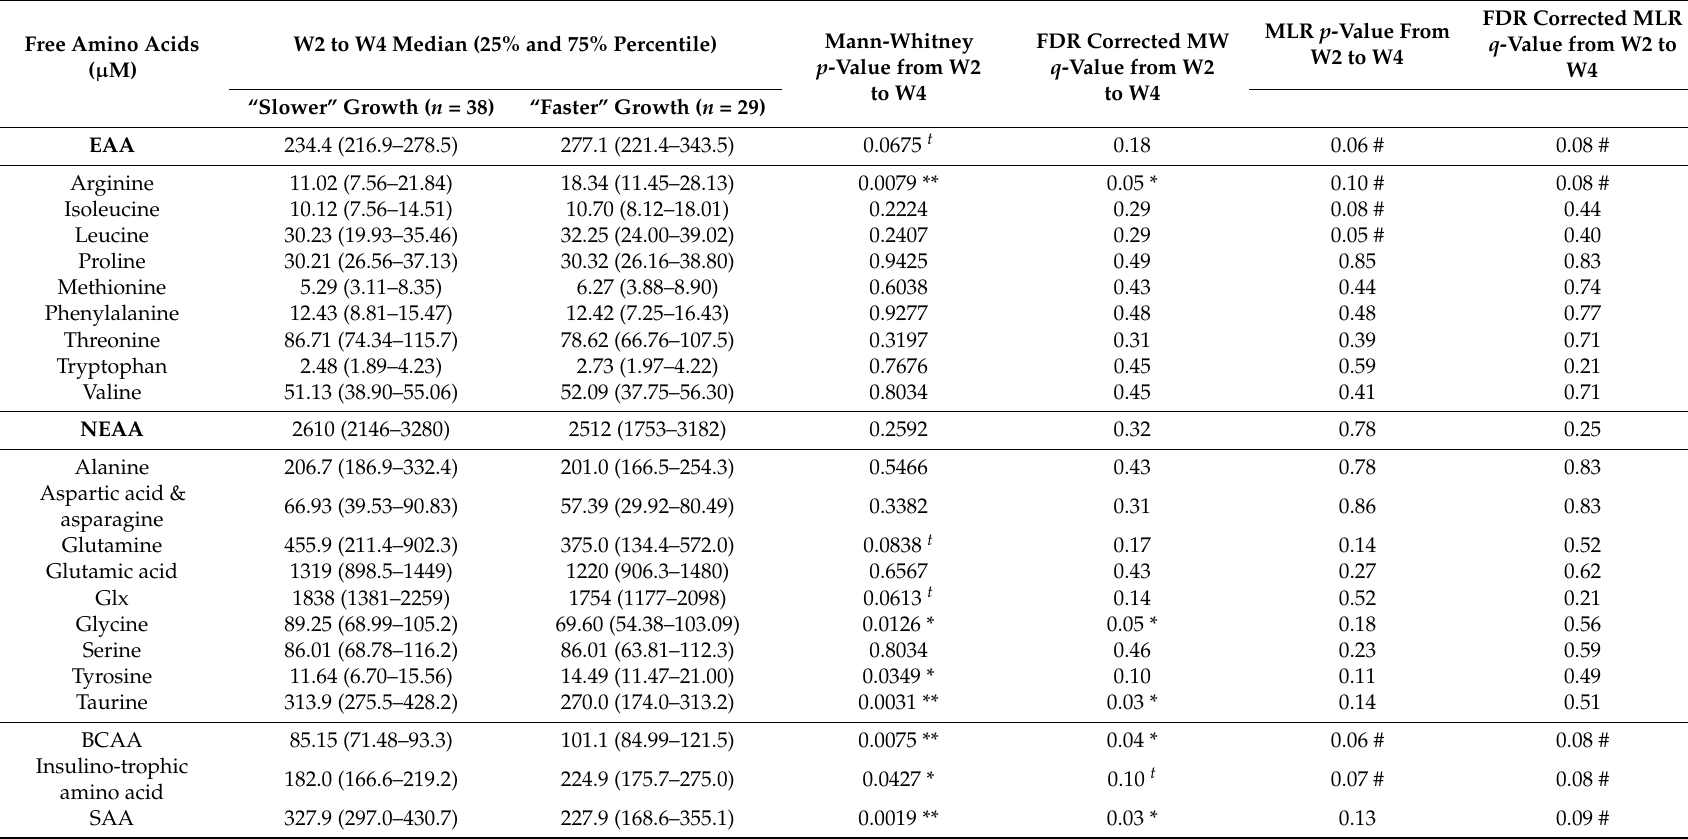
Table 2. Concentration levels of free amino acids in breast milk provided to preterm infants with “faster” or “slower” growth during the W2 to W4 lactation period. Free Amino